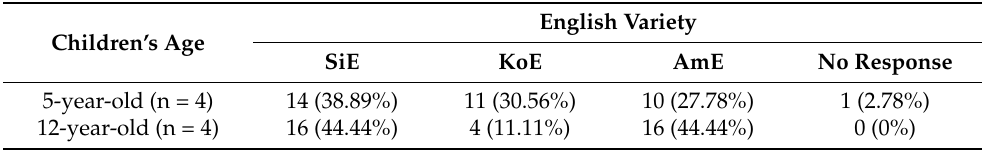
Table 4. The number of responses and percentage of 5-year-old and 12-year-old children’s ratings for the Singaporean, Korean, and American English speakers.